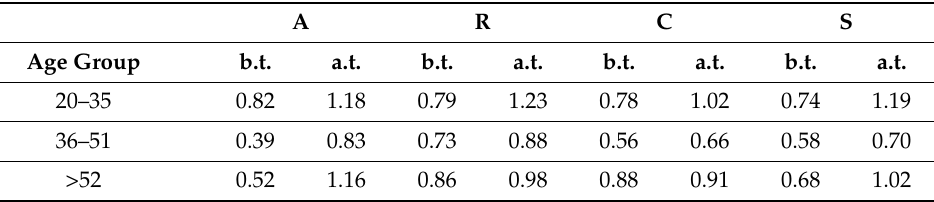
highest statistically significant differences were observed in the age group 20–35 and were between Attention and Confidence (test statistic: − 1.6478, p -value = 0.0497, p < 0.05)